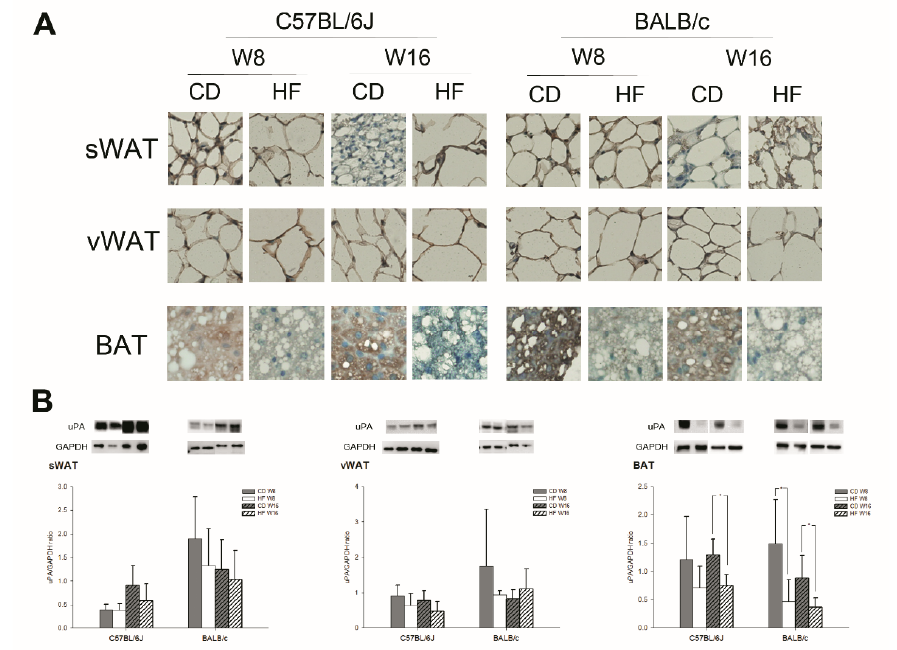
Figure 1. The ( A ) immunohistochemical stain and ( B ) Western blot for uPA expression on subcutaneous white adipose tissue (sWAT), visceral white adipose tissue (vWAT) and brown adipose tissue (BAT) in C57BL/6J and BALB/c mice ( n = 5, in each group). The uPA expression in sWAT and vWAT of CD and HFD groups did not differ significantly, but there was a significant decline in the BAT in the HFD group. All figures of IHC stain: 400×.